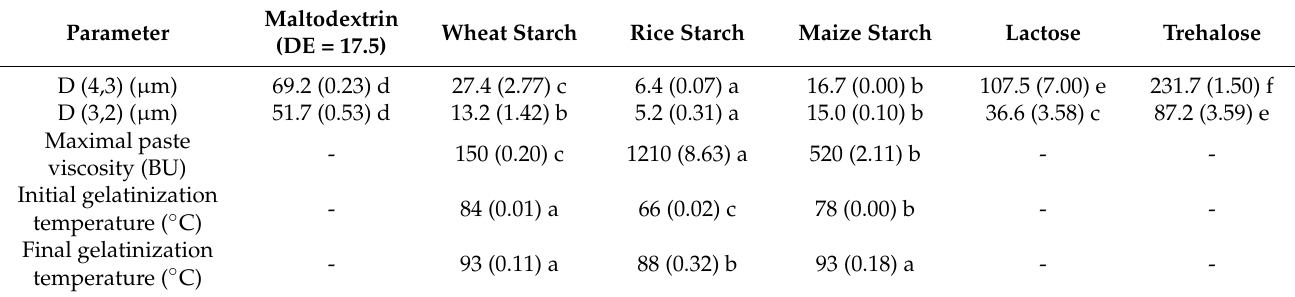
Table 1. Mean diameters and amylograph properties of used carbohydrate